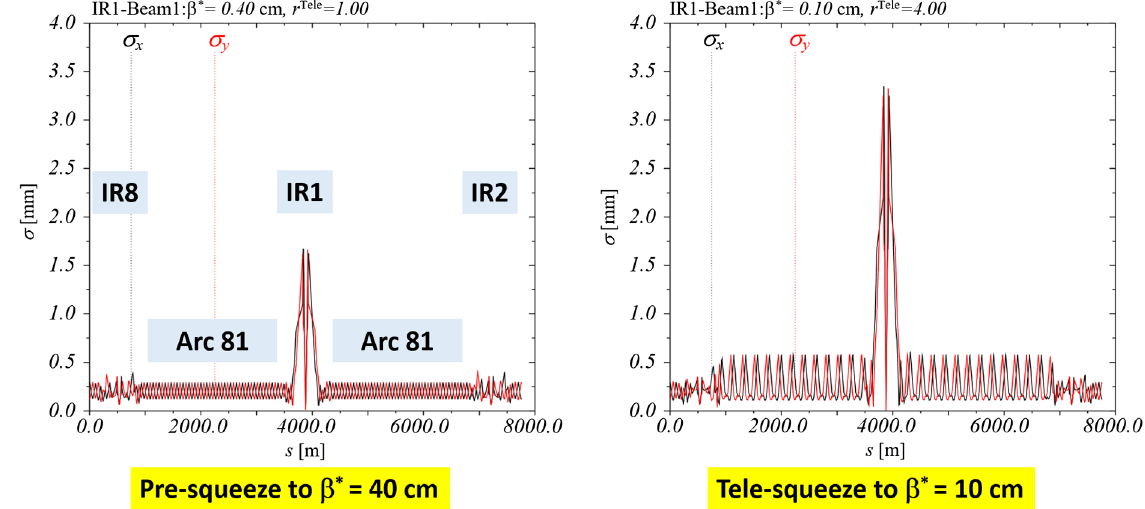
FIG. 1. Beam sizes [mm] at 7 TeValong a quarter of the LHC ring for a typical ATS presqueezed (left) and tele-squeezed (right) optics. The interaction point (IP) of the ATLAS experiment is exactly at the center. In the end of the tele-squeeze the spot size is not larger than 6 μ m at the IP, thanks to the ATS scheme transforming 7 km of machine into a giant final focus system with natural chromatic correction sections embedded in Arc81 and